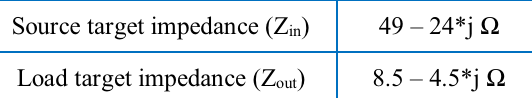
Table 1. Source and load target impedances.